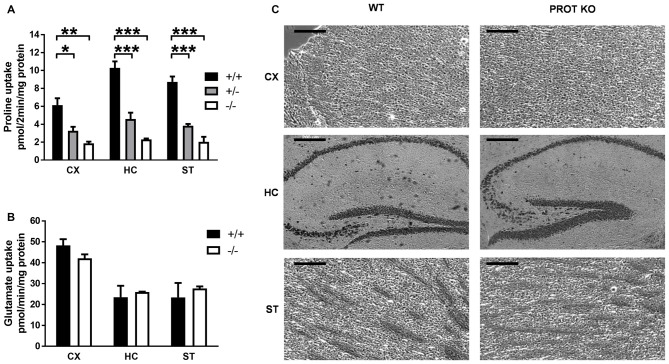
L-Proline transport activity is reduced in PROT−/− mice. (A,B) Membranes were prepared from the indicated tissues of WT (+/+), heterozygous (+/−), and homozygous (−/−) KO mice, and then assayed for L-proline uptake for 2 min (A) or L-glutamate uptake for 1 min (B) at 37°C. (C) Cresyl violet-stained sections from WT and PROT KO mice are shown. No defects were detected in the homozygous mutants, and the overall anatomy appeared normal in all animals analyzed. CX, cortex; HC, hippocampus; ST, striatum. Data are shown as means ± SEM (n = 3 for each genotype). (A) One-way analysis of variance (ANOVA) with Bonferroni’s post hoc test; (B) two-tailed Student’s t test; *p < 0.05; **p < 0.01; ***p < 0.001. Scale bars: 200 μm.